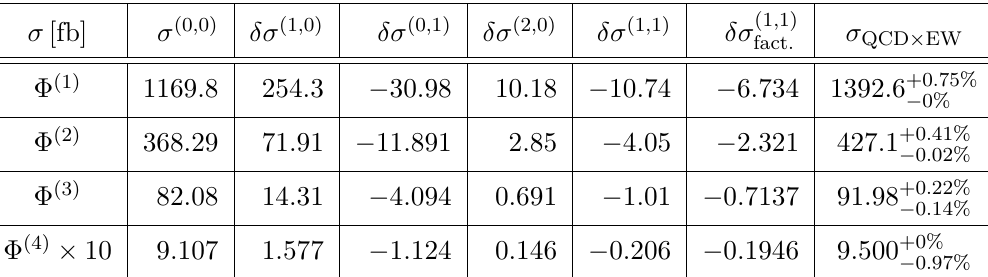
Table 2 . Fiducial cross sections in the invariant mass windows specified through eq. (4.5). We show the LO predictions, σ (0 , 0) and the higher-order ones, δσ ( i,j ) . In order to improve readability, we multiply the fiducial cross sections in the Φ (4) phase space by a factor 10. In the next-to-last column we quote the result of the factorized approximation defined in eq. (4.6). In the last column we show our best predictions obtained by including all the higher-order corrections considered in this paper, cf. eq.